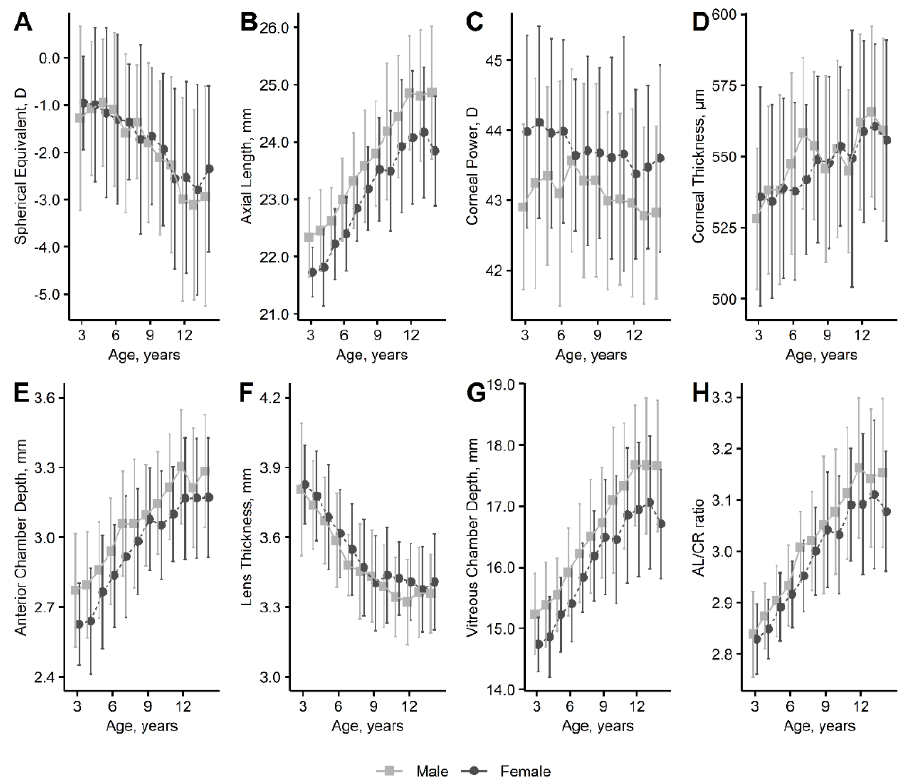
Figure 2. Sex- and age-specific distribution of ocular biometry. The means and 95% confidence intervals are shown. ( A ), Spherical equivalent. ( B ), Axial length, ( C ), Corneal power. ( D ), Corneal thickness. ( E ), Anterior chamber depth. ( F ), Lens thickness. ( G ), Vitreous Chamber depth. ( H ), AL/CR. D = diopter; AL/CR ratio = axial length – corneal radius ratio.